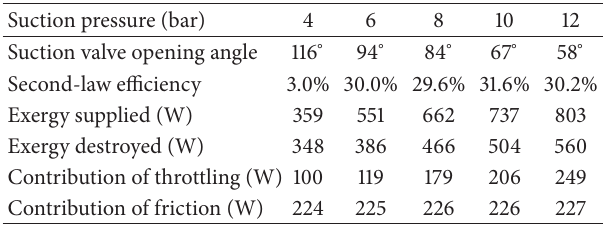
Table 3: Data of variation of suction reservoir pressure.